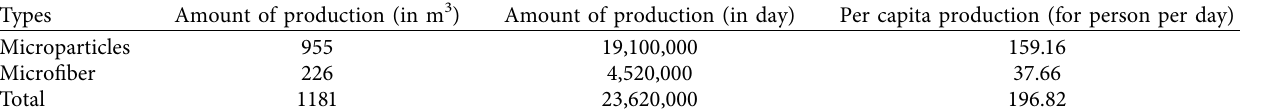
Table 8: Per capita production of microplastic particles according to the output waste.